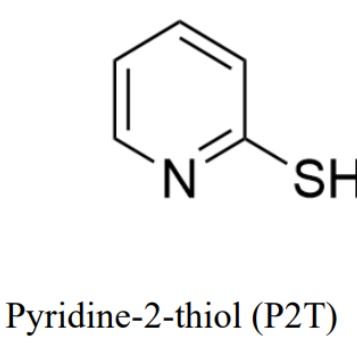
Figure 1. Molecular structure of pyridine-2-thiol (P2T), the inhibitor used for this